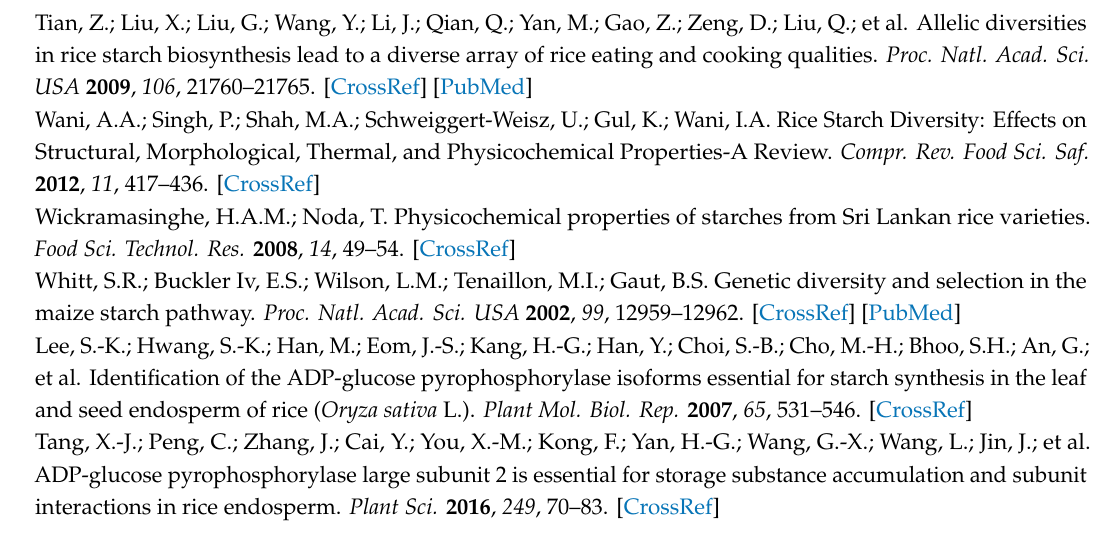
Table S1: Primers used for sequencing the whole genome sequence of flo4-5 and qRT-PCR in this study, Table S2: Primer sequences of CAPS markers that developed for fine mapping, Table S3: Compare the whole genome sequences of cyOsPPDK gene among Nipponbare, flo4-5 and its wild type Namil. InDel (Insertion or Deletion). Author Contributions: H.W., T.-H.H. and S.-W.K.; developed ideas, designed and performed all experiments, and wrote the manuscript. Y.M. and J.-U.J.; developed the mutant lines and mapping population. D.-E.I. and J.L.; analyzed the whole genome resequencing dates. S.M.L. and S.-G.J.; produced rice plants for experiments.